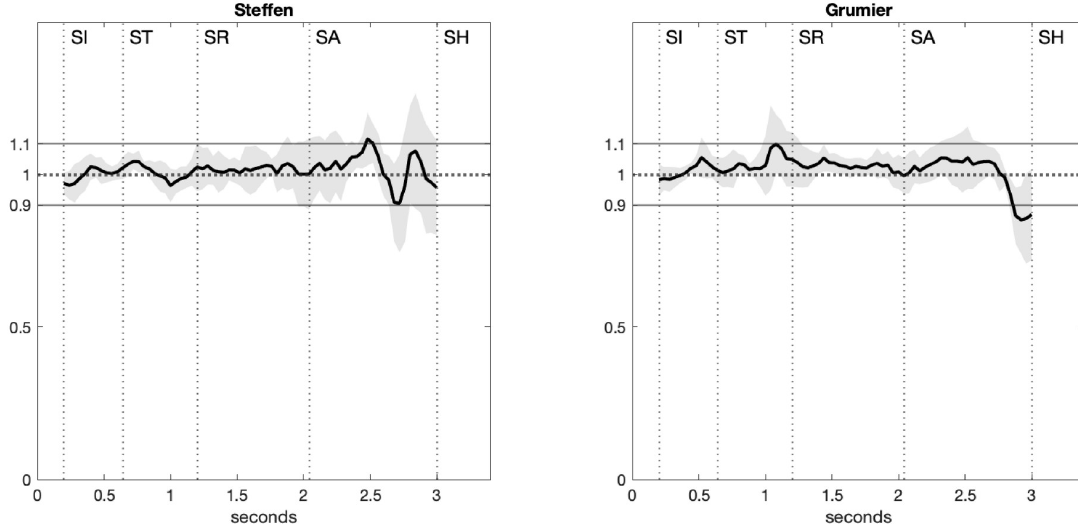
Fig 12. Average relative length. The average relative length of the five segments of the kinematic model is in the range 1 ± 0.1 except for a few peaks of standard deviation during offensive actions.